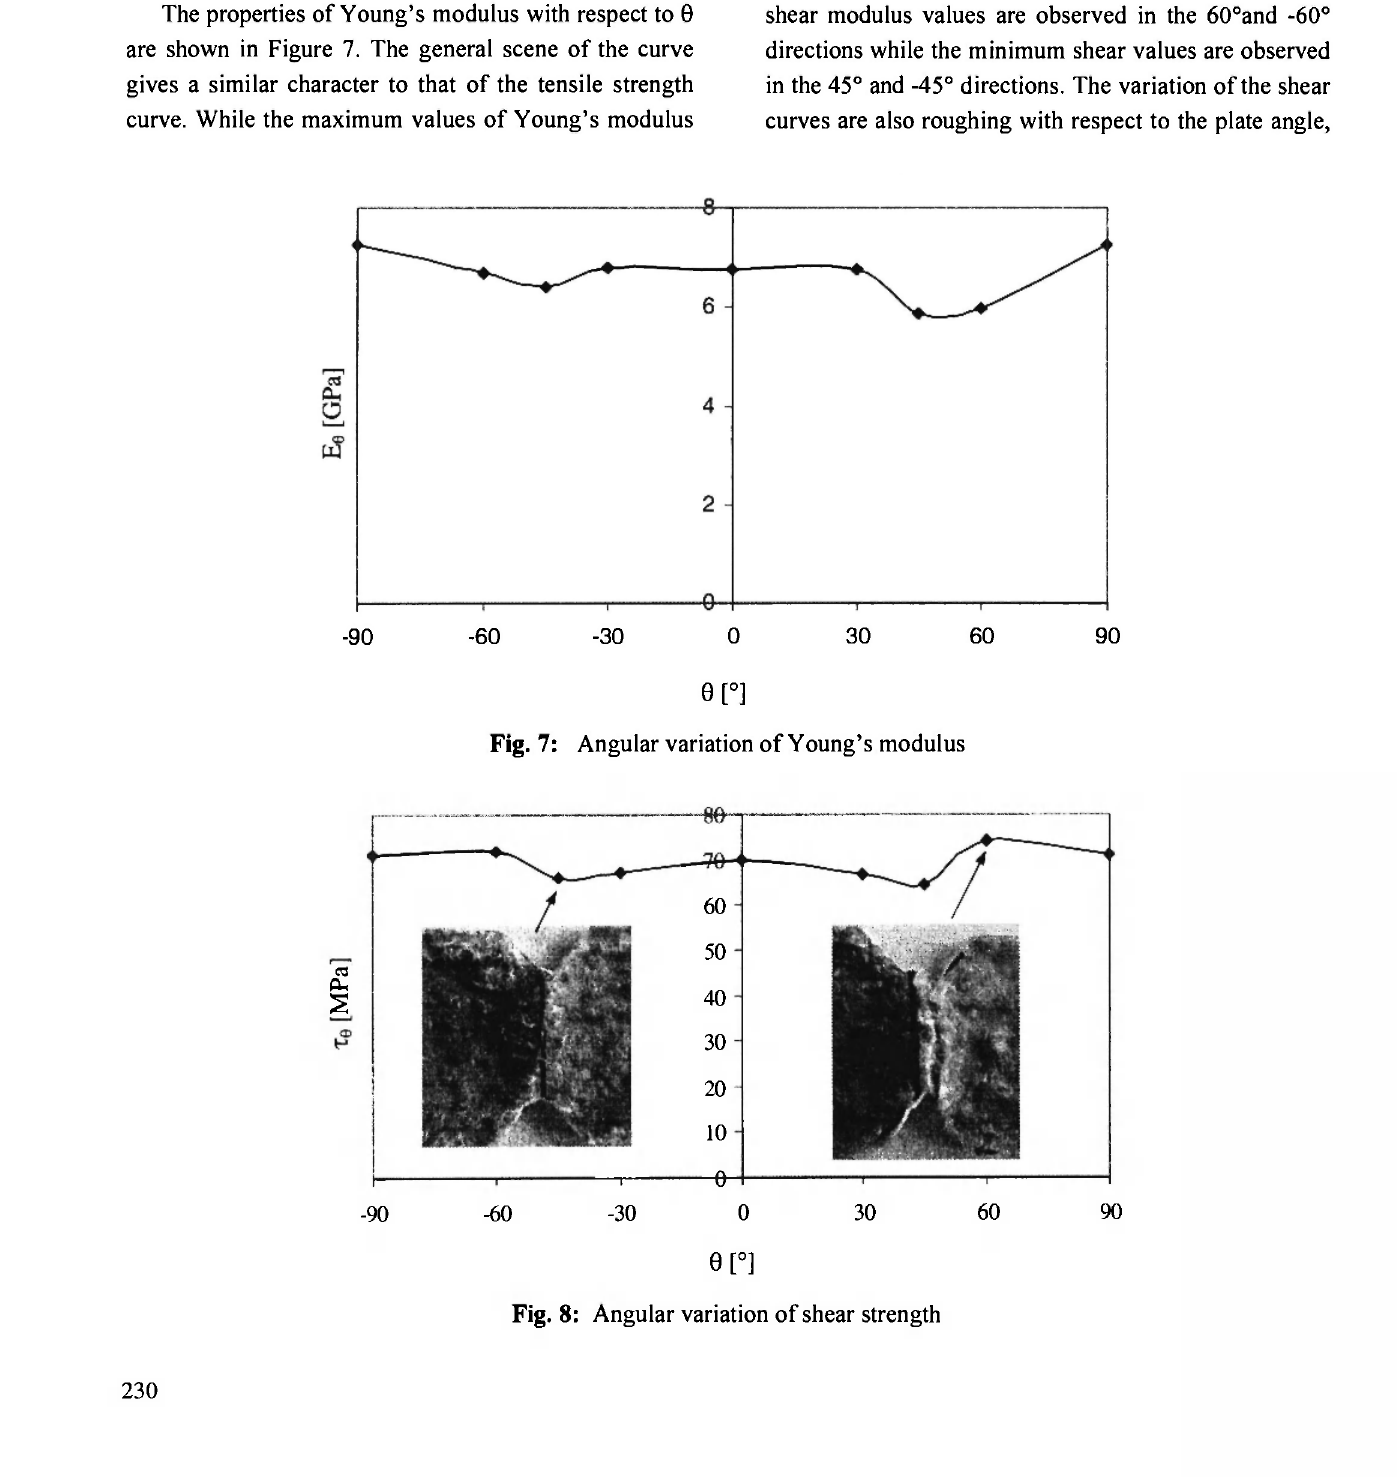
Fig. 7: Angular variation of Young's modulus